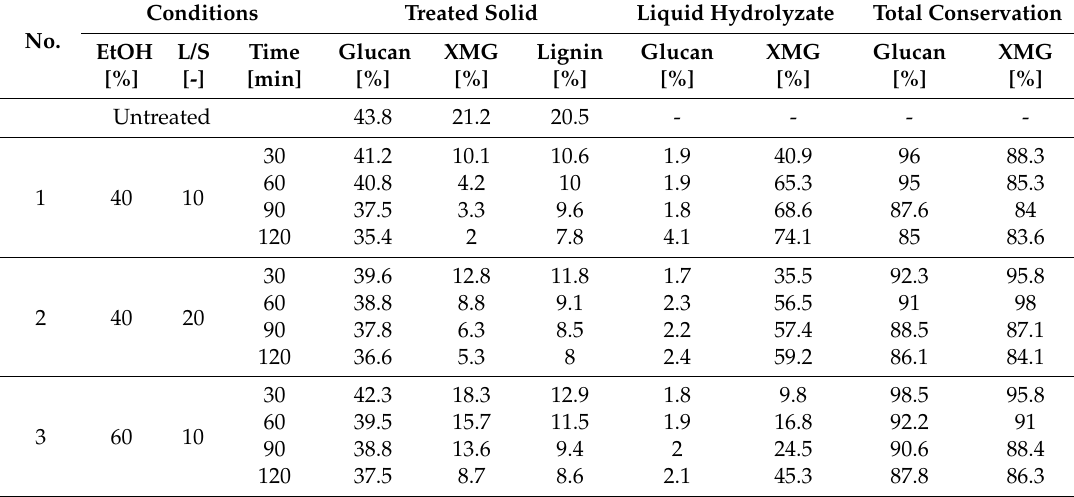
Table 2. Chemical compositions of solids and liquid hydrolyzates and total conservation yield of ball mill organosolv pretreatment under various reaction